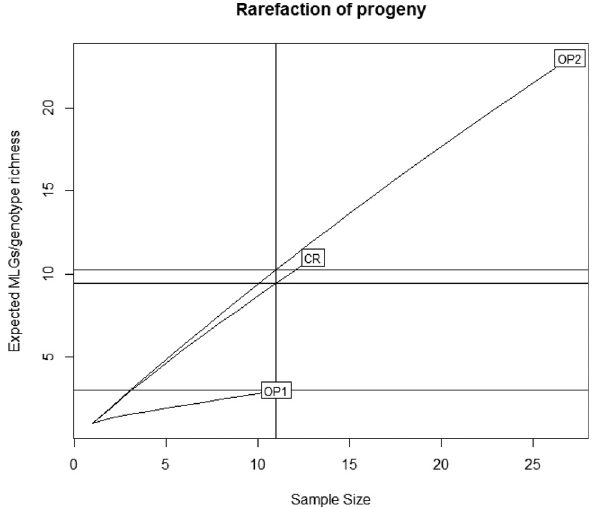
Figure 4 - Rarefaction curve for progenies indicating the number of ex- pectedmultilocusgenotypes(eMLGs)togetherwiththeminimumnumber of samples in each progeny. CR: cross pollinated progeny; OP1: open pol- linated progeny 1; OP2: open pollinated progeny 2.